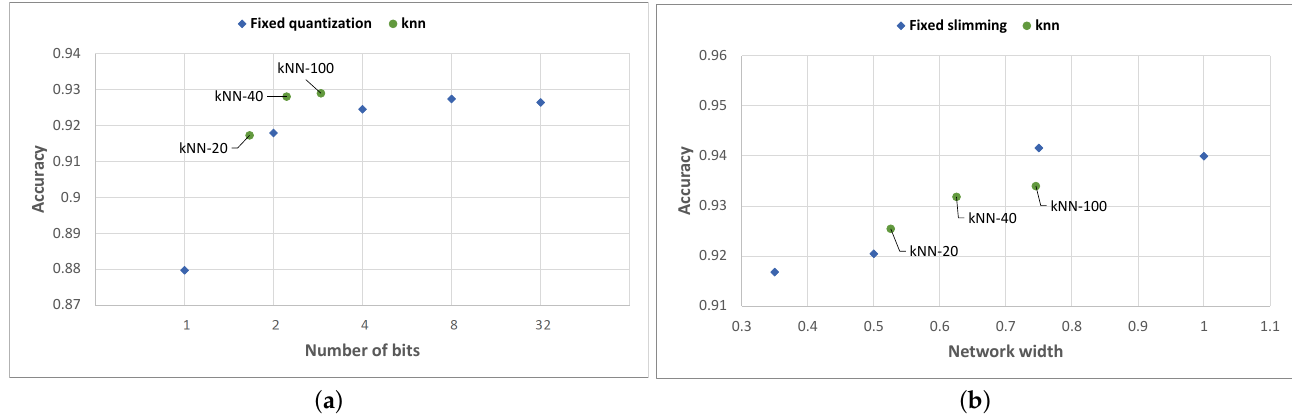
Figure 7. Accuracy of k-NN based compression level selection algorithm. The blue dots show the accuracy that can be achieved with static compression. ( a ) Any-Precision. ( b ) SNN (Slimmable Neural